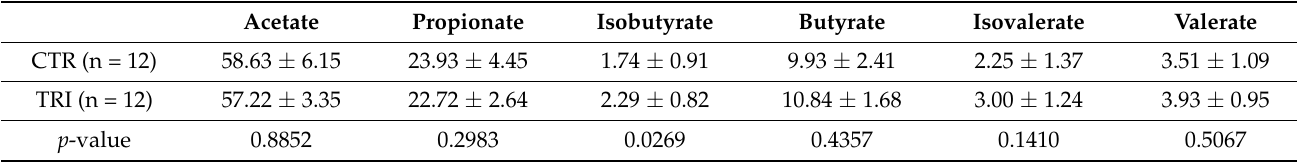
Table 1. Mean values of short-chain fatty acid (SCFA) concentrations of tributyrin (TRI) and control (CTR) piglet samples. Data are presented as mmol% ± SD.